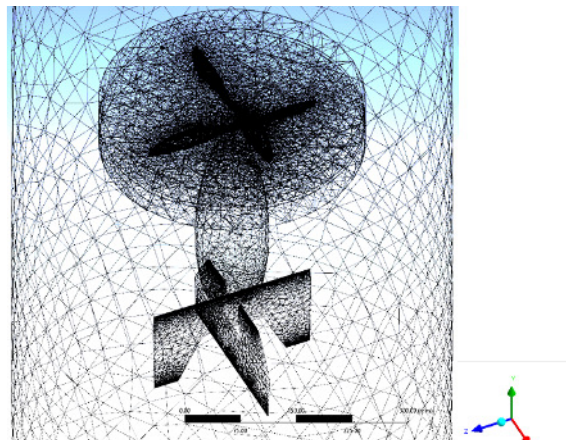
Figure 5. MCR UAV v3.0 meshing of different control